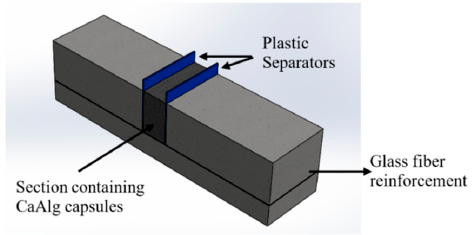
Figure 2. Schematic of the mold separation to incorporate the CaAlg capsules to the middle section.